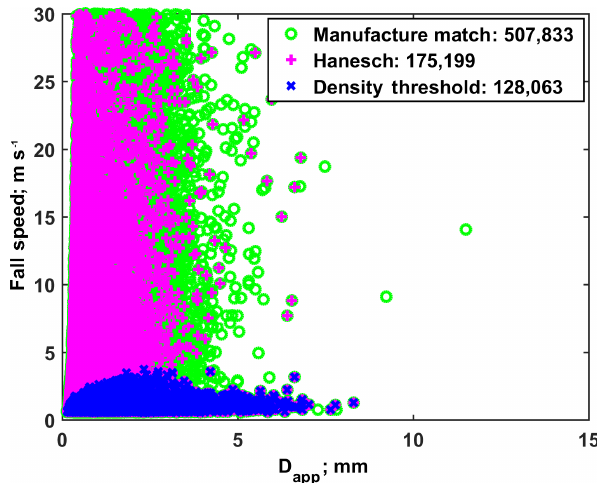
Figure 3. Fall speed vs. D app for the synoptic case on 31 Jan- uary 2012 at the CARE site. The green circles represent the results of the manufacturer’s matching algorithm, which is known to allow mismatched particles with unrealistic fall speeds. The first filter- ing step is the selection of matched particles which satisfy Hanesch scan line criteria (magenta). The second filter step is shown as blue crosses, which are based on particles with density (from mass com- puted by Böhm’s or Heymsfield–Westbrook method) lower than 1gcm − 3